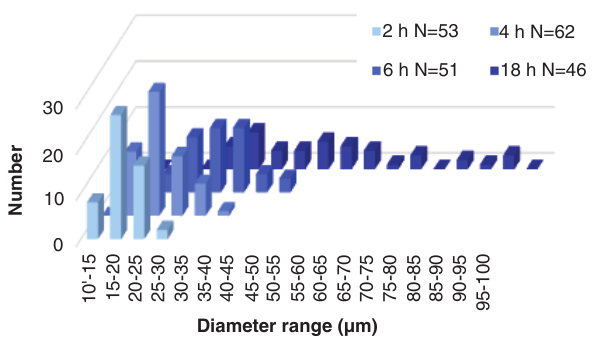
Supplemental Figure S5. HNK-1 +ve ENS cells aggregate progressively. Aggregate diameter increased on average and the range of diameters increased over the period 2 h to 18 h in rotation aggregation assays. Starting cell density was 0.3×10 6